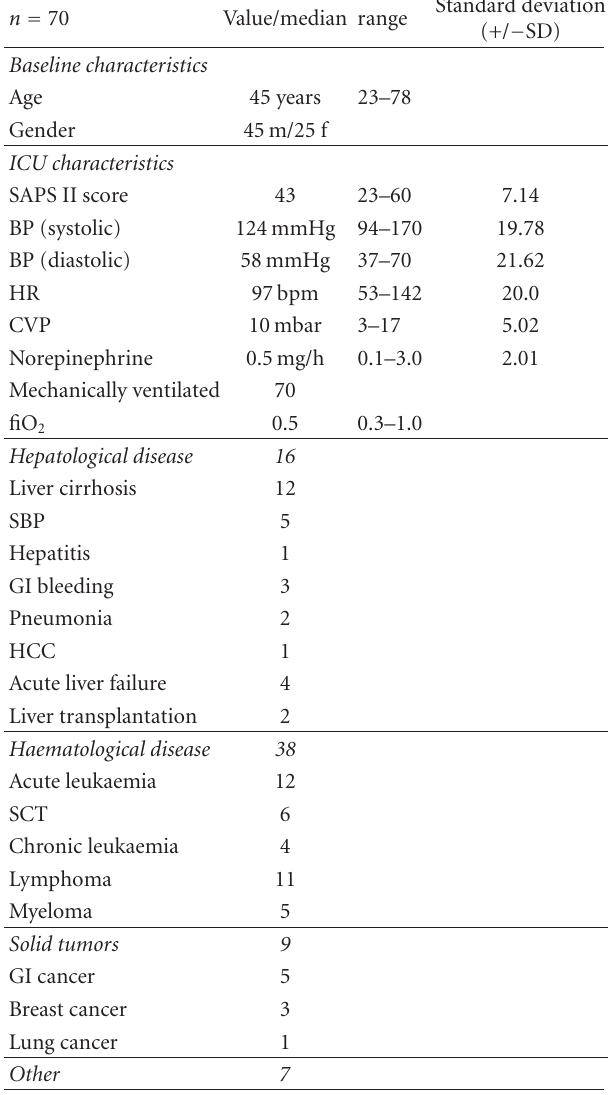
Table 1: Patient characteristics.